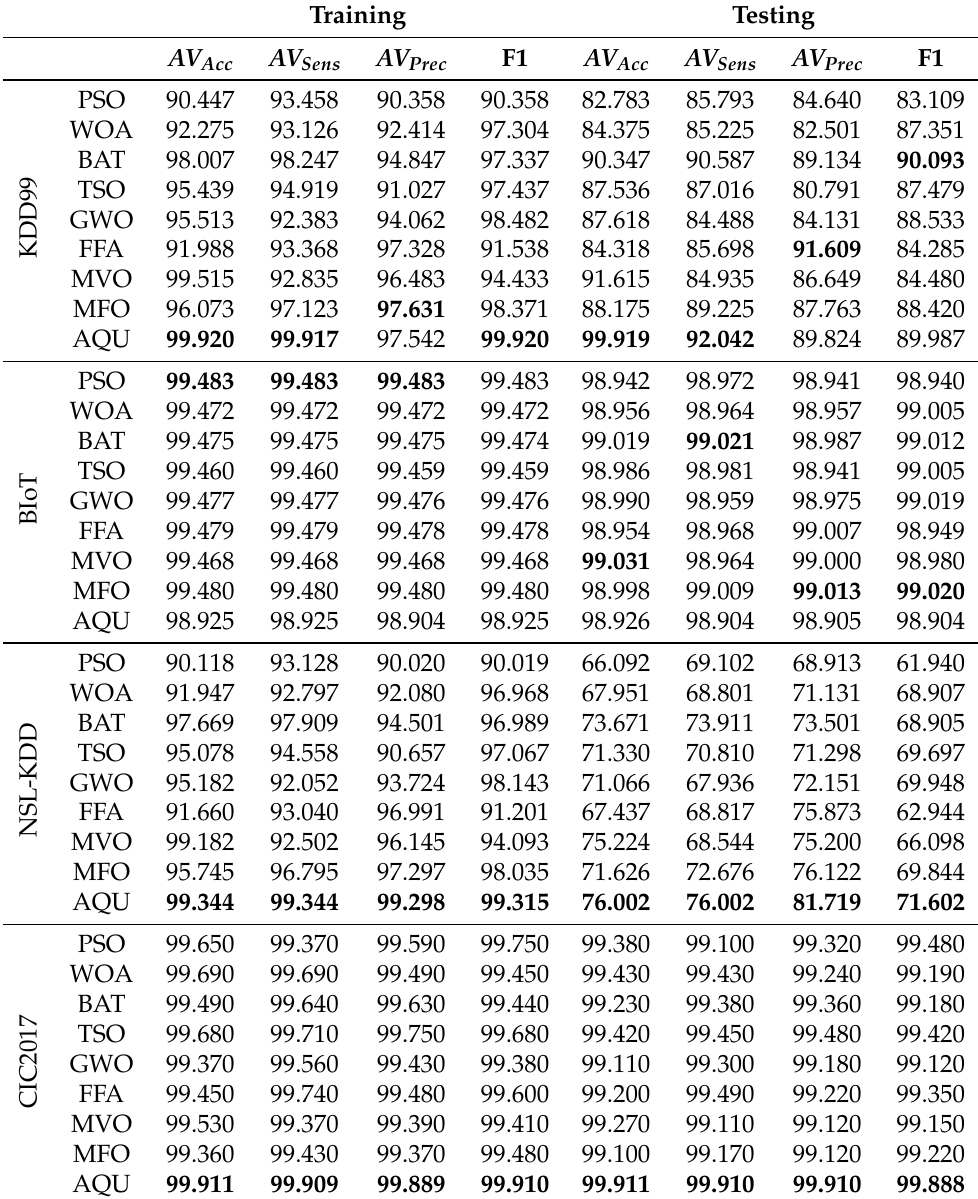
Table 2. Results of developed AQUa for the datasets in case of